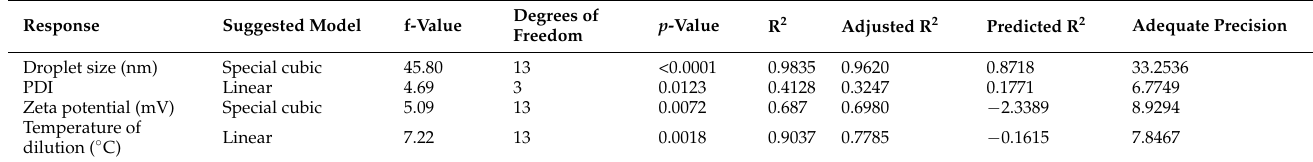
Table 4. Analysis of variance of the suggested models.